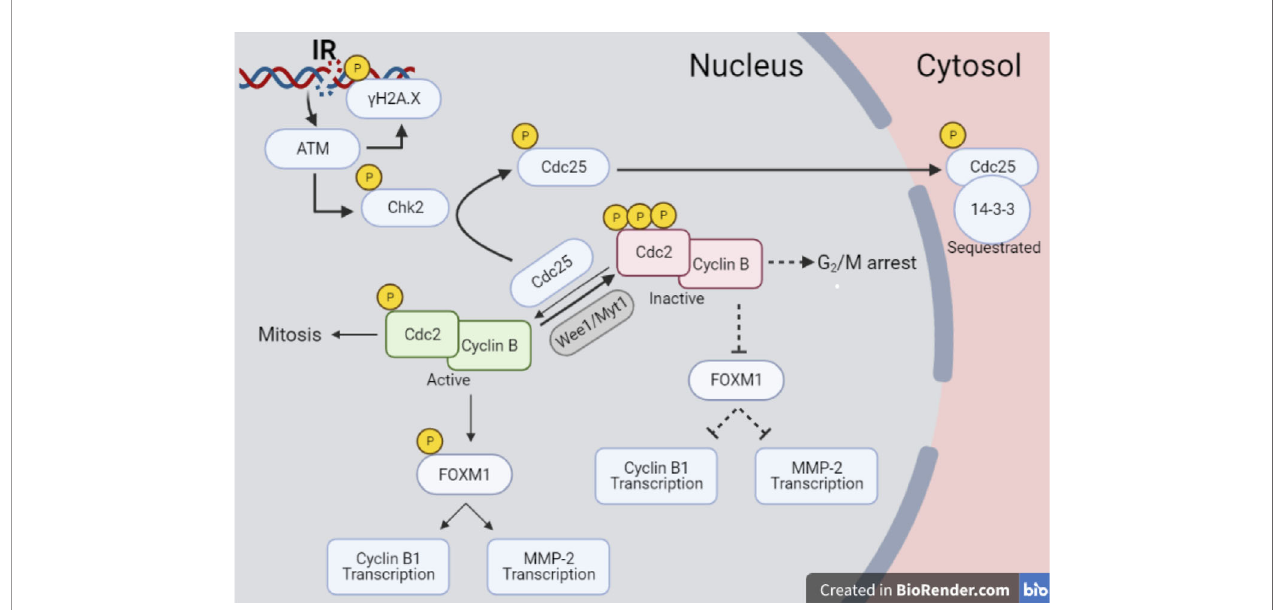
FIGURE 10 | Pathway scheme of Caco-2 response to X-rays. Illustration with the proposed reconstruction of the chain of events started by radiation exposure of Caco-2 cells at a molecular level, starting from initial DNA damage and including several proteins involved in cell cycle regulation, particularly focusing on the G 2 /M transition. Illustration created with